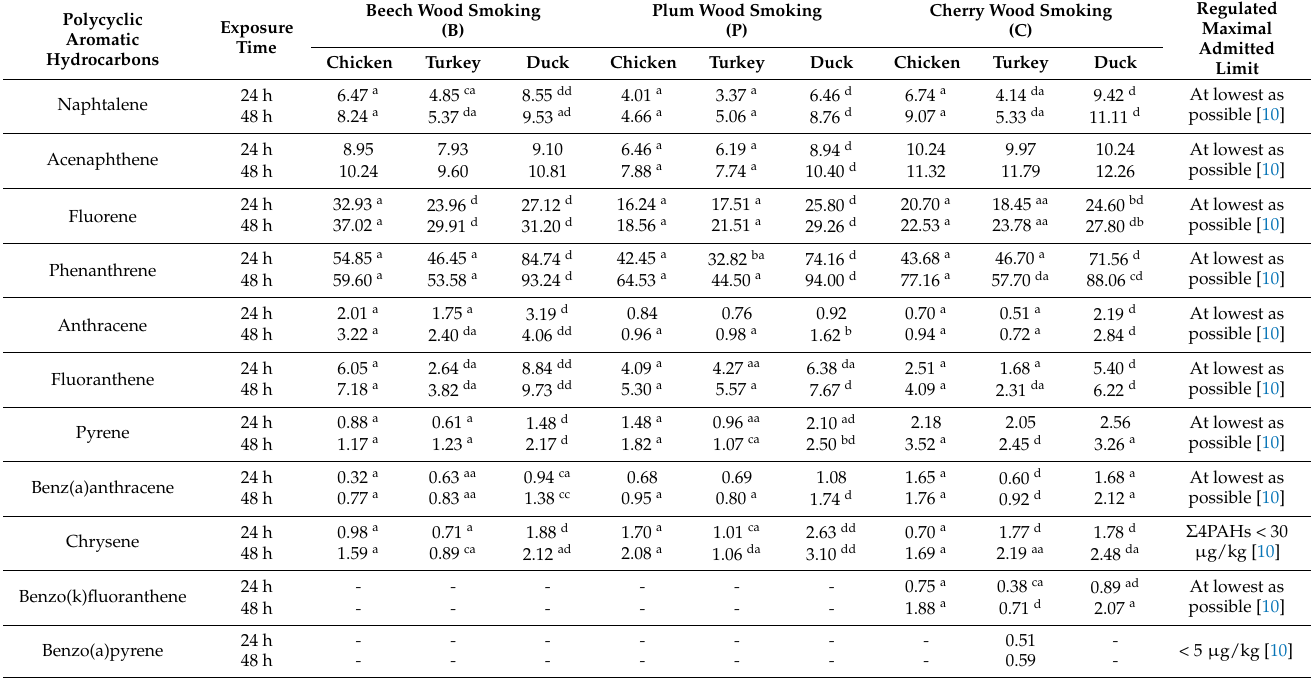
Table 5. Analysis of variance of total PAHs accumulation in meat, under the influence of poultry species (arithmetic means, µ g PAH/kg meat,